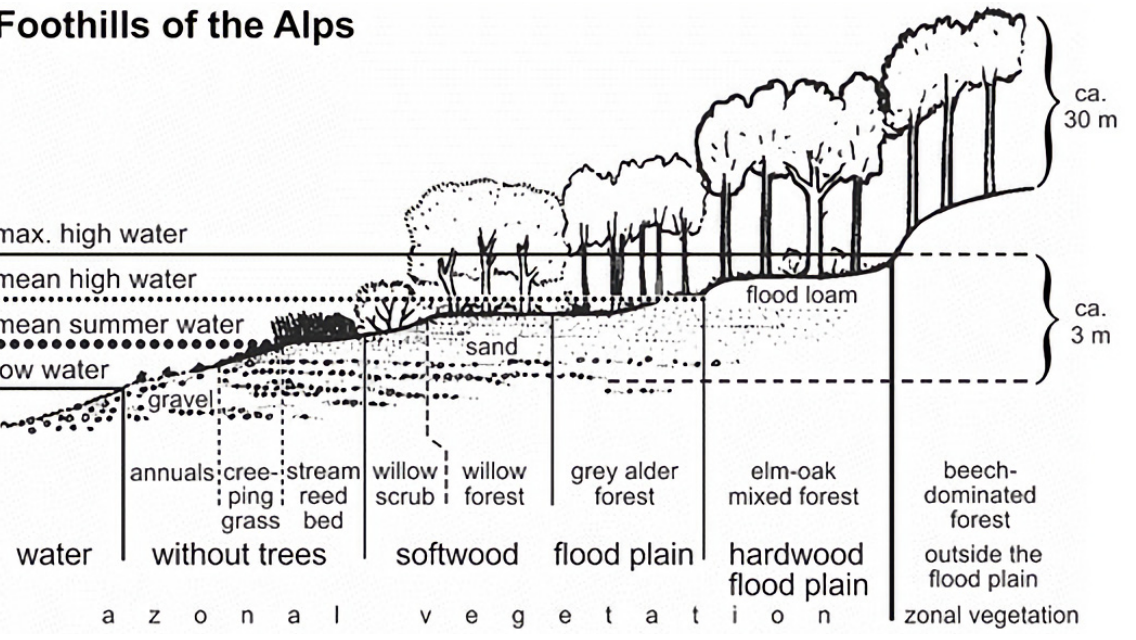
Figure 1. A schematic profile through a series of floodplain plant communities (from [22]). The riverbanks are frequently inundated, but sometimes they are very dry for long periods, and they are colonised by herbaceous pioneer annual plants ( Chenopodium and Polygonum ). Perennial tall grasses and reeds grow when inundation is infrequent. Riverside willow scrub with Salix purpurea and S. triandra usually forms a narrow strip along low gravel or sand banks, which are replaced by the often flooded riverside woodlands of S. alba (white willow) and Alnus incana (grey alder). Hardwood woodlands dominated